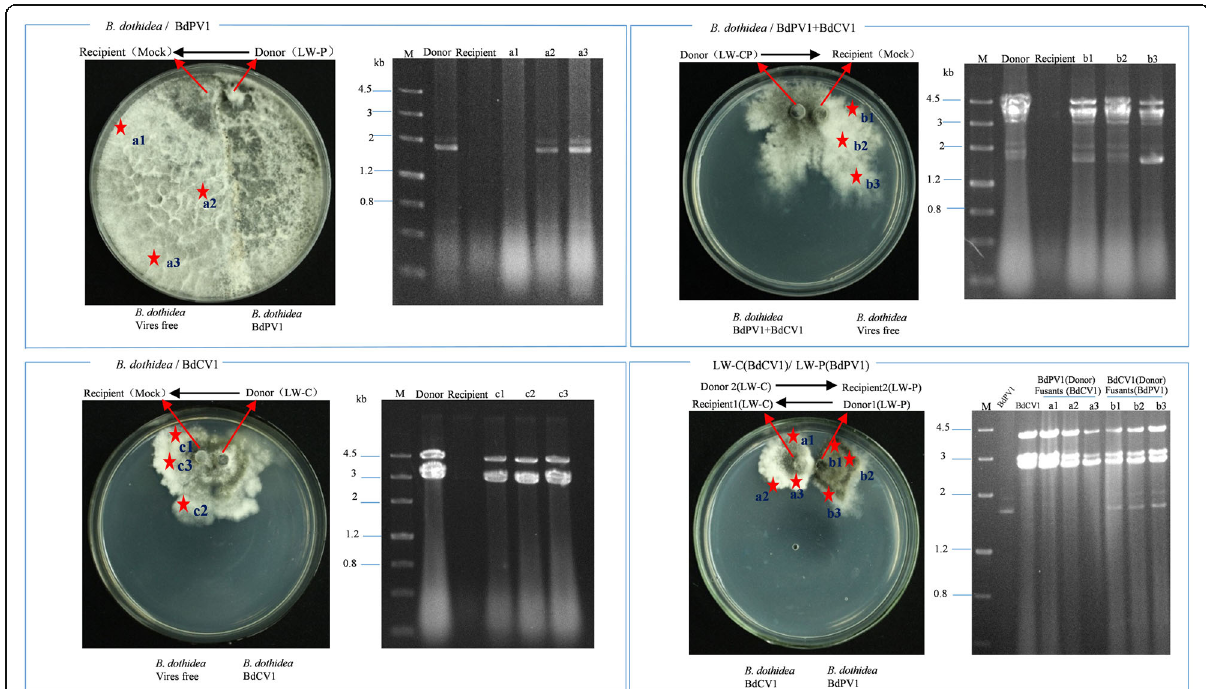
Fig. 3 Horizontal transfer of mycovirus and dsRNA analysis of Botryosphaeria dothidea derivates. a1, a2, a3; b1, b2, b3; c1, c2, c3 represent derivates infected with